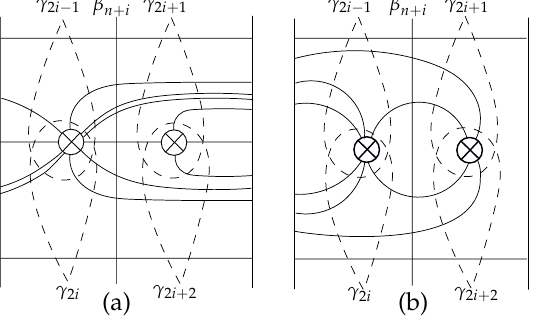
Figure 14. ( a ) Example for Case 2(i) and ( b ) example for Case